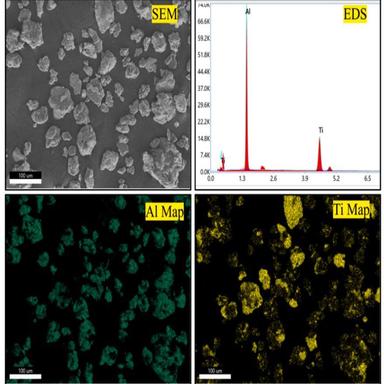
EDS elemental mapping of powder for 10 h of MA.